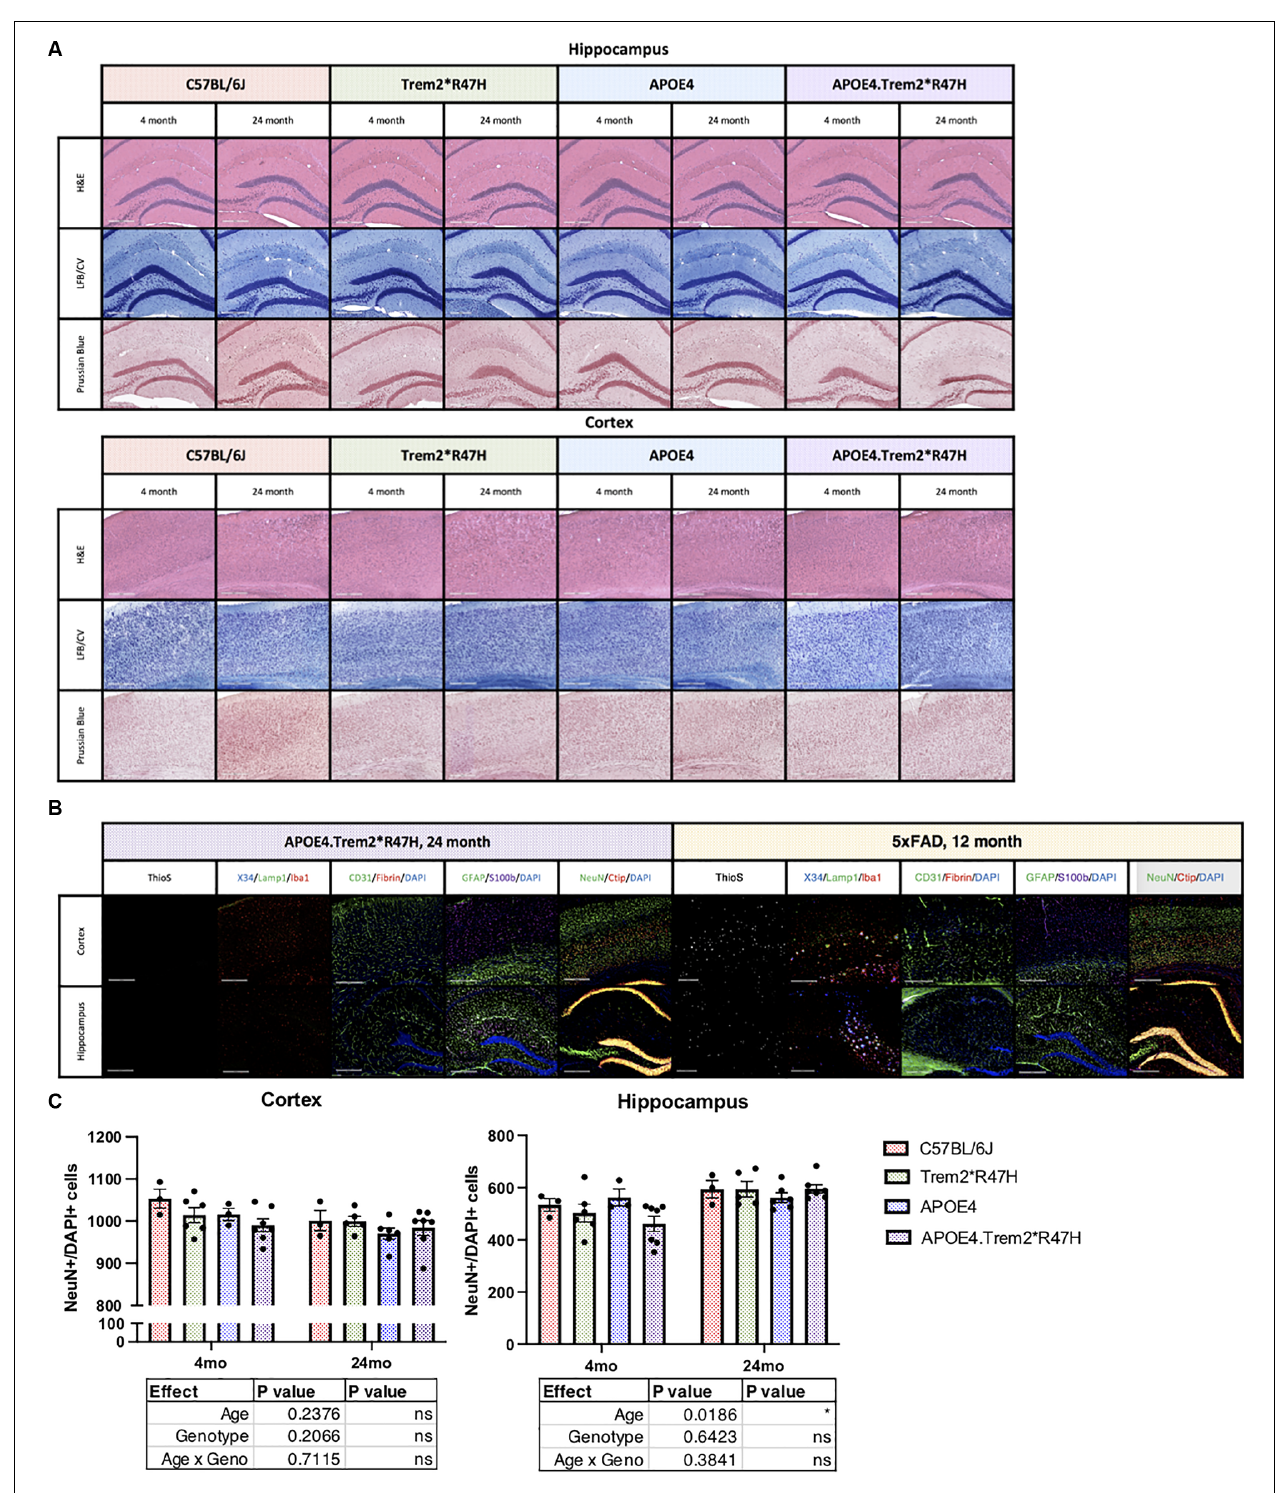
FIGURE 5 | Neuropathological analysis of cortex and hippocampus. Hematoxylin and eosin (H&E), luxol fast blue/cresyl violet (LFB/CV), and Prussian blue staining tissue staining protocols (A) to identify anatomical changes in the cortex and hippocampus of young and aged mice. Thioflavin S (Thios) and four combinations of known neuropathological markers of LOAD in aged mice, 5xFAD included as amyloidogenic positive control (B) . Neuropathological analysis of cortex and hippocampus. Neuron (NeuN) cell populations were quantified in panel (C) . Age- and genotype-dependent differences determined by two-way ANOVA. Factor effects and effect interaction displayed in tables. * p < 0.05; ** p < 0.01; *** p < 0.001. All alleles expressed were